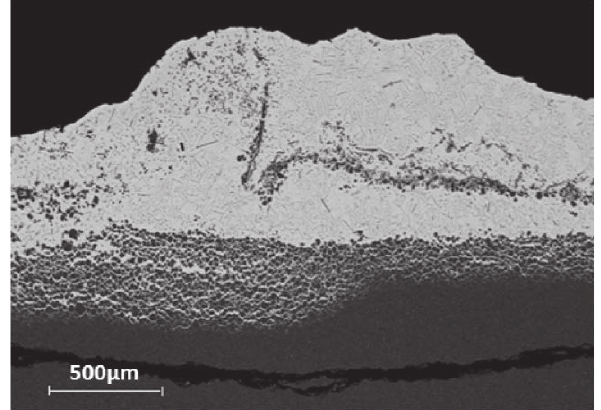
Fig. 12: SEM-BSE image showing a broad cross-section of the specimen from experiment 5 FeNi6.5 (15 min)